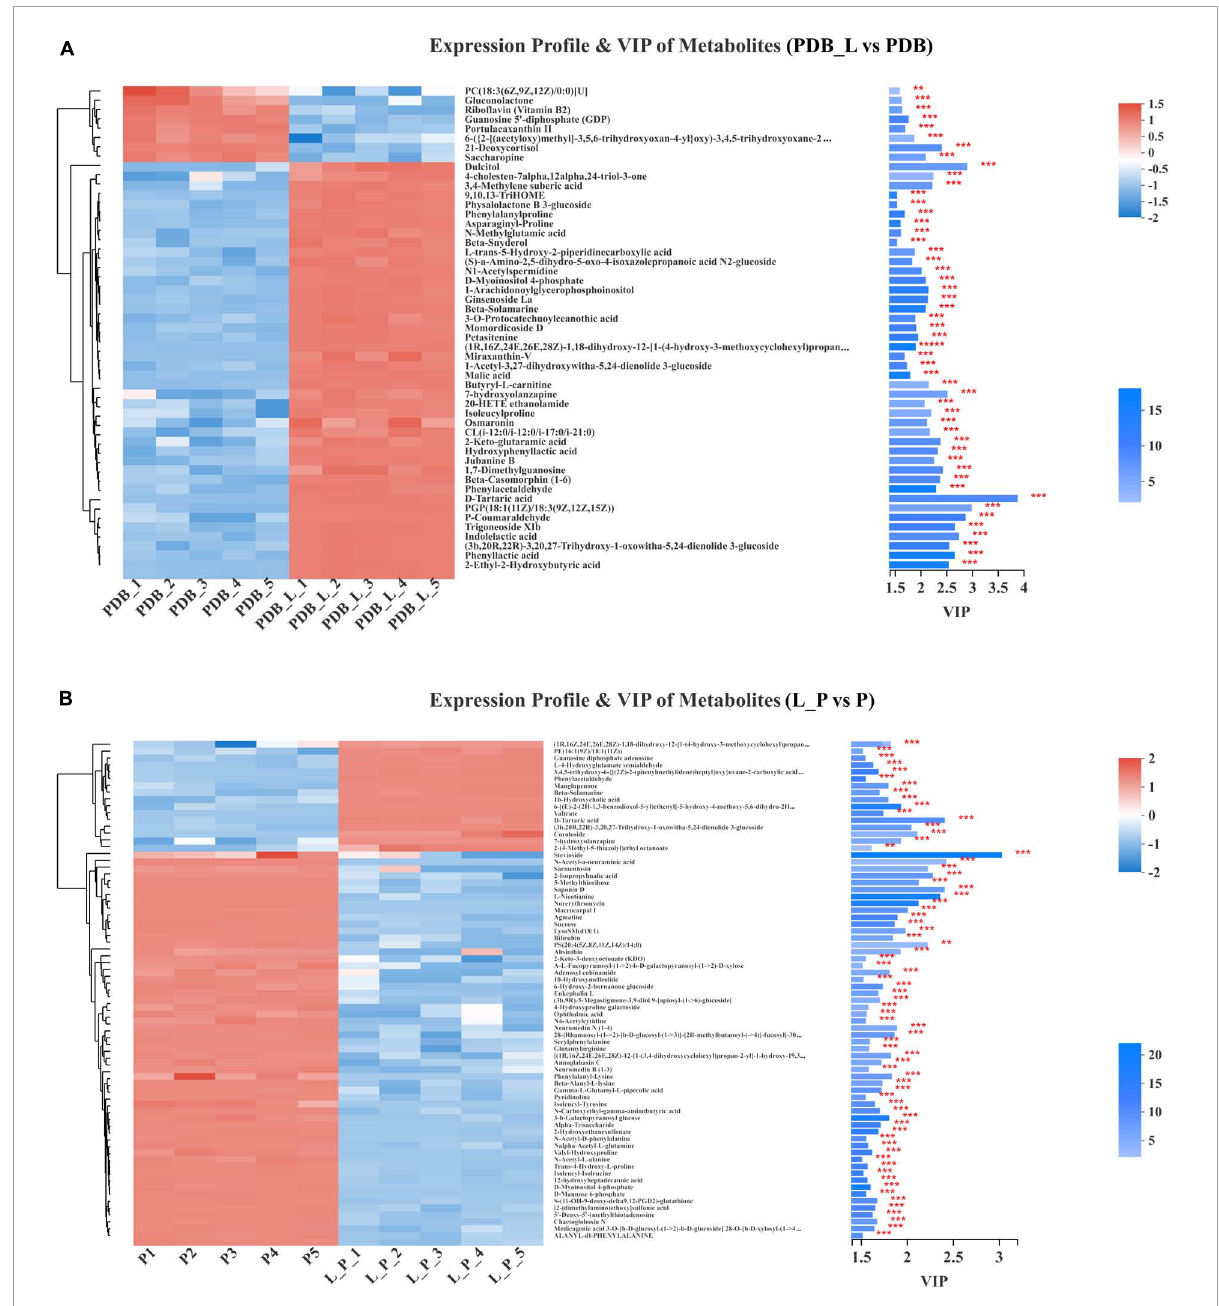
FIGURE7 Comparison of the relative abundance of metabolites in PDB_L vs. PDB groups (A) and in L_P vs. P groups (B) . Levels of significance are defined as ** p < 0.01 and *** p <